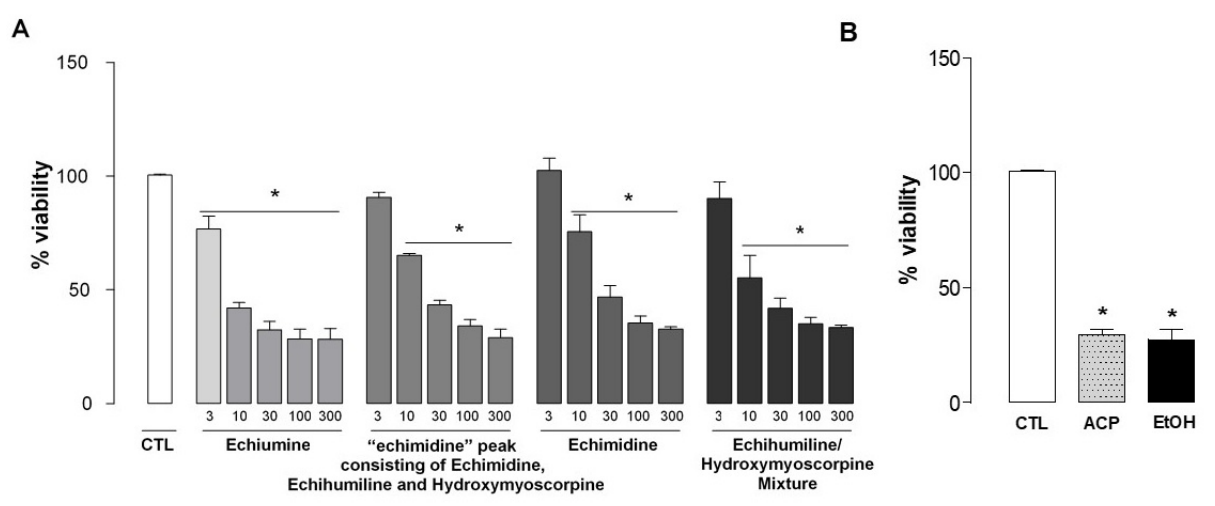
Figure 5. Effect of the compounds on cell viability in primary culture of rat hepatocytes. ( A ) Rat hepatocytes were treated with echiumine, a fraction with an “echimidine” peak, echimidine or echihumiline/hydroxymyoscorpine mixture (3–300 µg/mL) for 48 h. ( B ) Rat hepatocytes were treated with acetaminophen (ACP; 15.1 mg/mL) or ethanol (EtOH; 80 µL/mL) as a positive control. Cell viability was determined by MTT assay. The results are expressed in percentage of control (CTL) and each column presents the mean and the SEM of triplicate assays of two independent experiments. * p <0.05 when compared with control (CTL) values (one-way ANOVA or t -test, when applicable). Table 2. Mean IC 50 and maximal inhibitions values on cell viability in primary culture hepatocytes for different compounds.